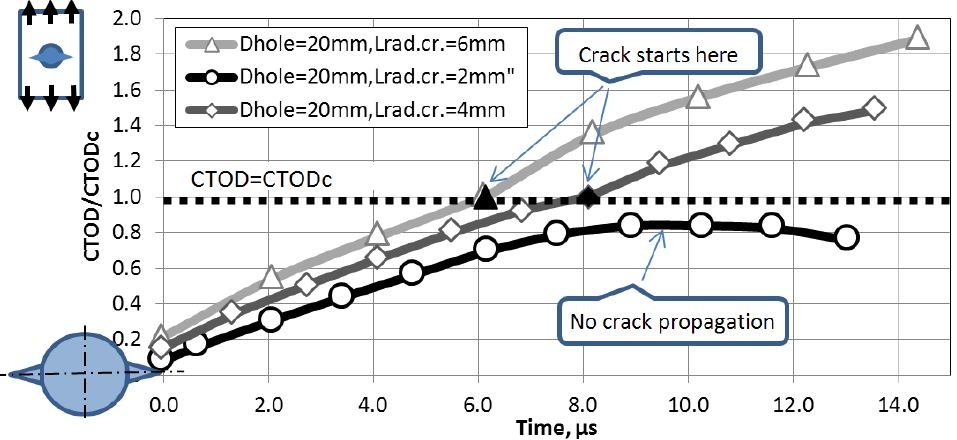
Figure 8: Evolution of the crack tip opening